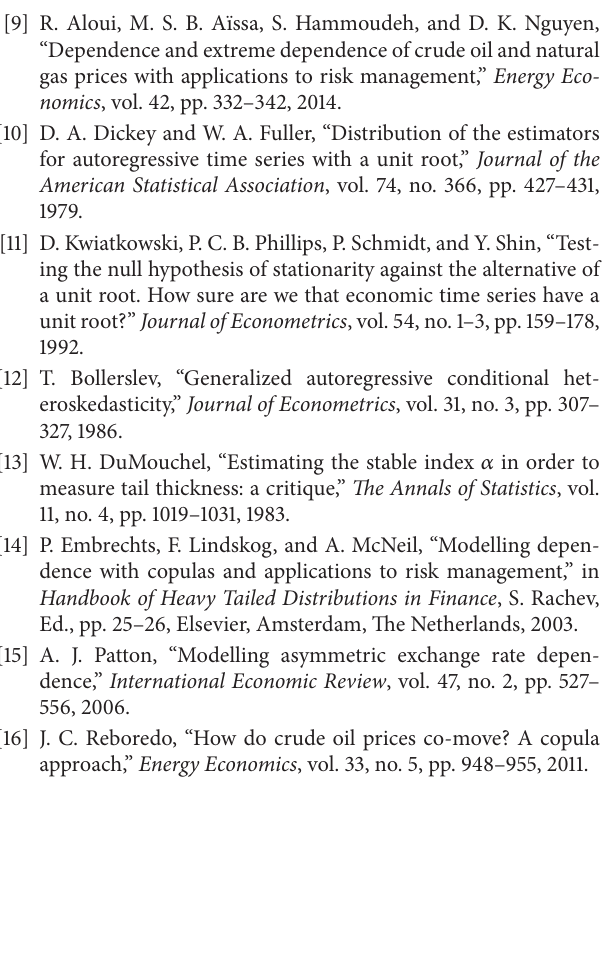
Table 8: Optimal investment proportion of natural gas portfolio with minimum risk. Copula Confidence level VaR Corresponding CVaR 0.90 0.0130 0.0154 Normal copula 0.95 0.0169 0.99 0.90 0.0126 0.0159 Student 𝑡 -copula 0.95